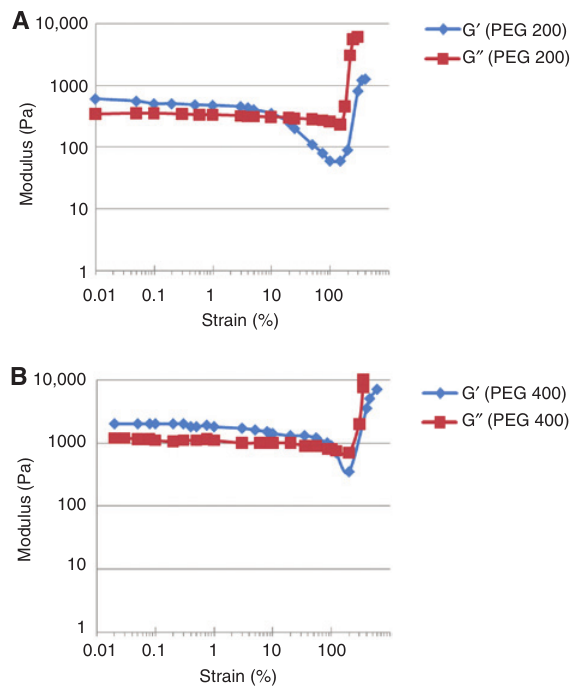
Figure 11: Modulus diagram based on strain percentage for the 40 wt% silica sample in (A) PEG 200 and (B) PEG 400.